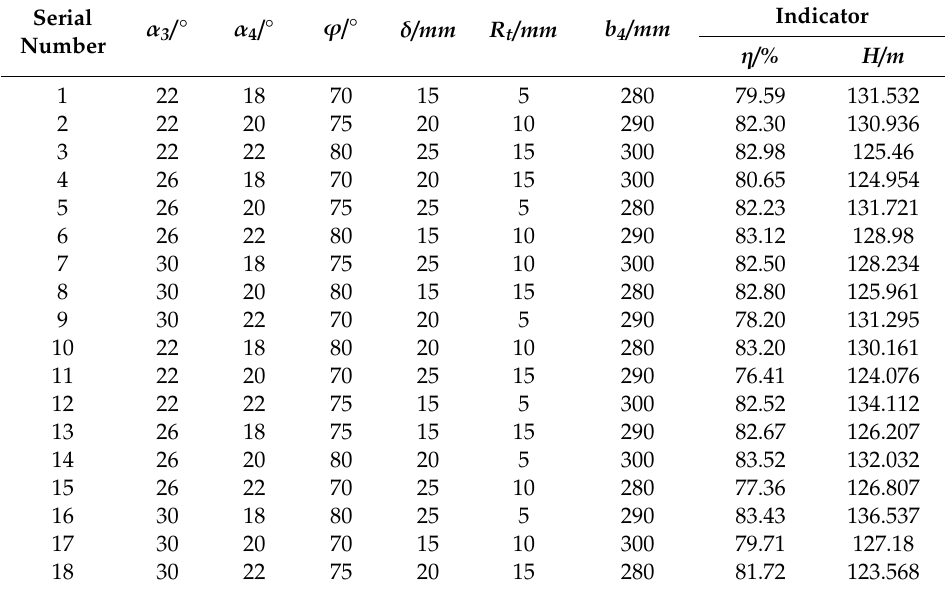
Figure 2. The water model and grid diagram of the reactor coolant pump. Table 2. Numerical calculation results of the orthogonal test.